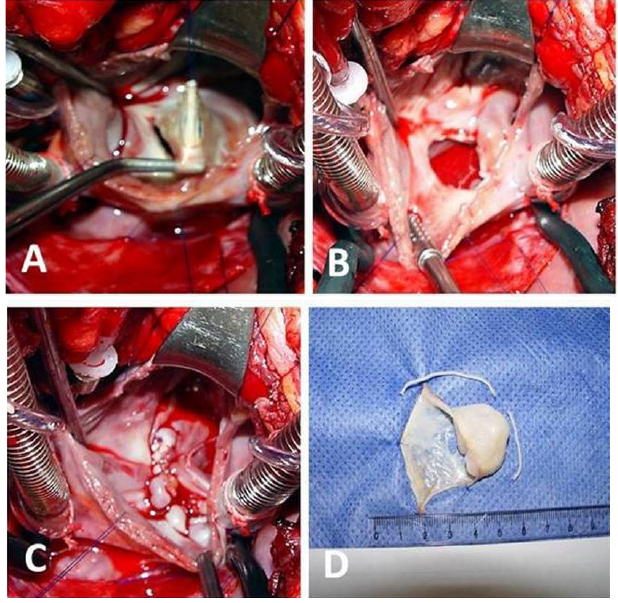
Fig. 3 - Surgical images. A) Atrial septal aneurysm (ASA) pulled up through the atrial septal defect exposed by a right atriotomy; B) fossa ovalis after ASA excision; C) atrium septorhaphy; D) excised aneurysm.